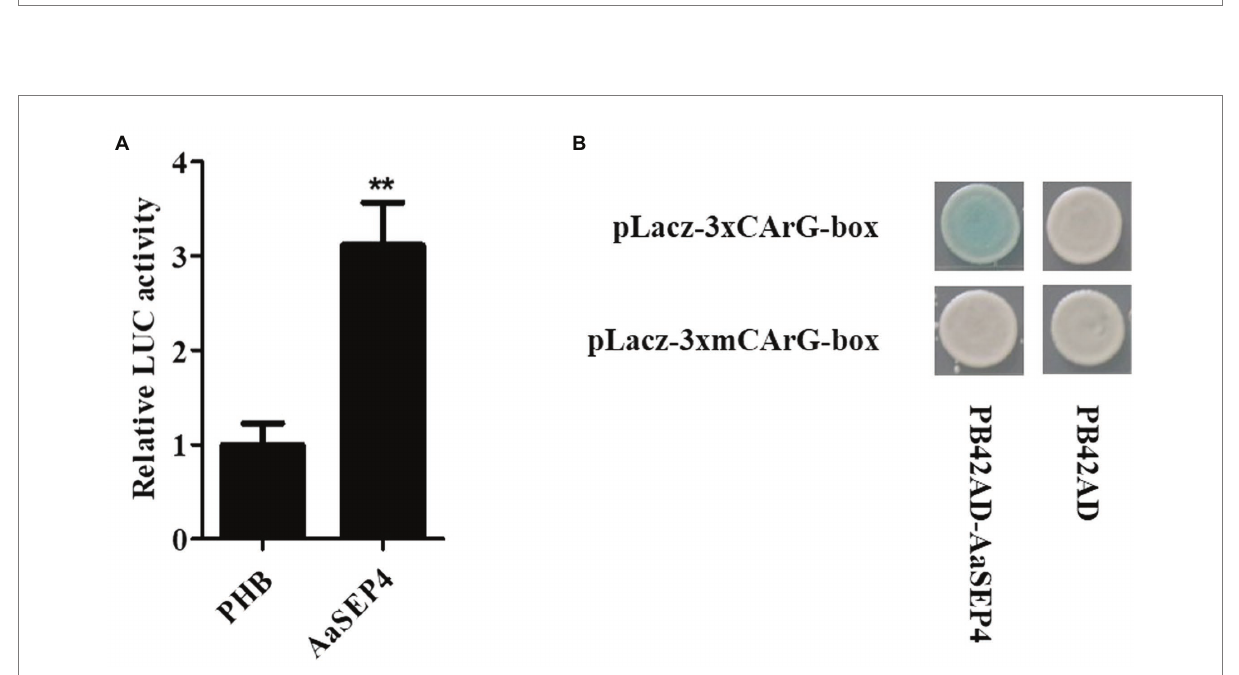
FIGURE 4 AaSEP4 directly binds and activates the promoter of AaGSW1 . (A) Transient dual-LUC detected in tobacco leaves. Effects of AaSEP4 on AaGSW1 promoter activation. The relative LUC activity was normalized to the reference Renilla (REN) luciferase. Error bars indicate SD ( n = 3). Student’s t -test: ** p < 0.01. (B) Yeast one-hybrid assay of AaSEP4 and GArG-box motif in promoter of AaGSW1 . Empty vector pB42AD was used as a negative